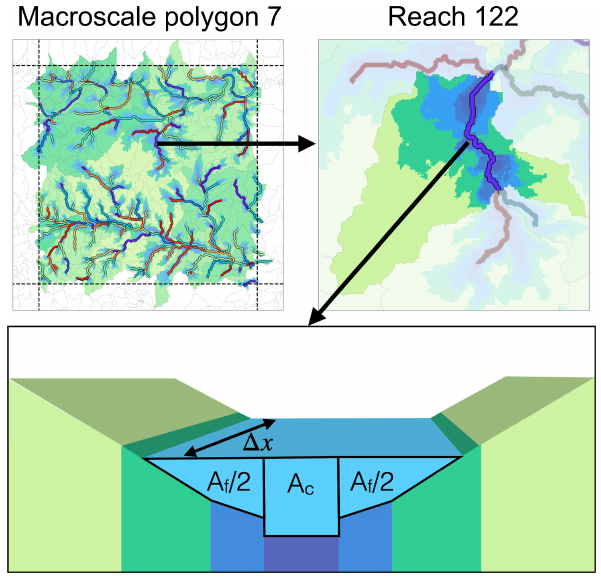
Figure 3. The illustration of a river reach in the domain. Using the HAND values, the river reaches are split into a channel (dark blue) and floodplain component (lighter blue and greens), where the floodplain component is a combination of the floodplains and hillslopes. Note that a few height bands are omitted in the diagram for simplicity. Similar profiles are assembled for each reach in each macroscale